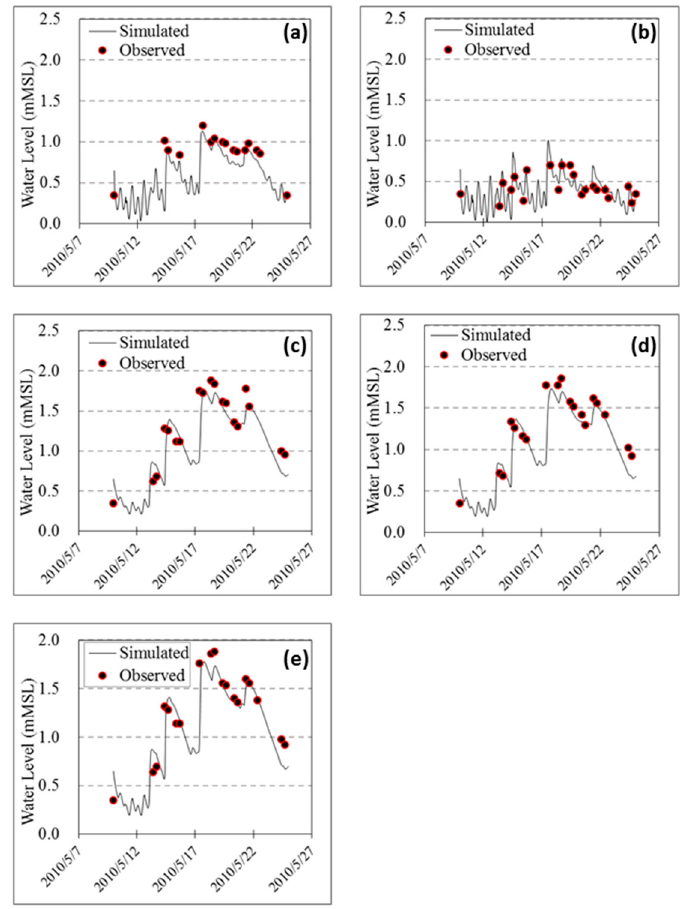
Figure 9. Water level comparison for the model validation: ( a ) Galle Road Bridge in Wellawatta canal; ( b ) Galle Road Bridge in Dehiwela canal; ( c ) SLLRDC Bridge in Heen Ela canal; ( d ) Kirimandala Bridge in Heen Ela canal; ( e ) Railway Bridge in Torrington canal.